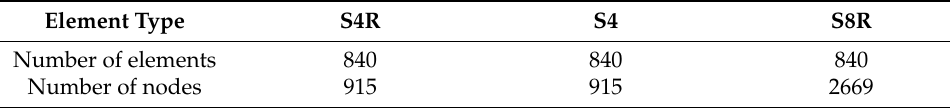
Table 4. FE mesh properties for different element types.